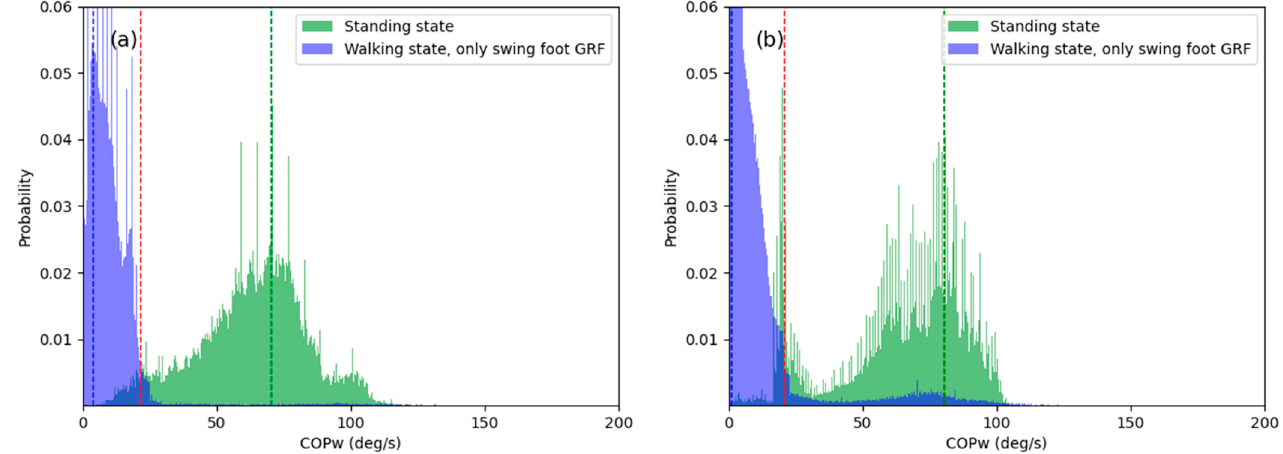
Figure 7. Histogram of ground reaction force (GRF) data: ( a ) healthy adults ( b ) patients.